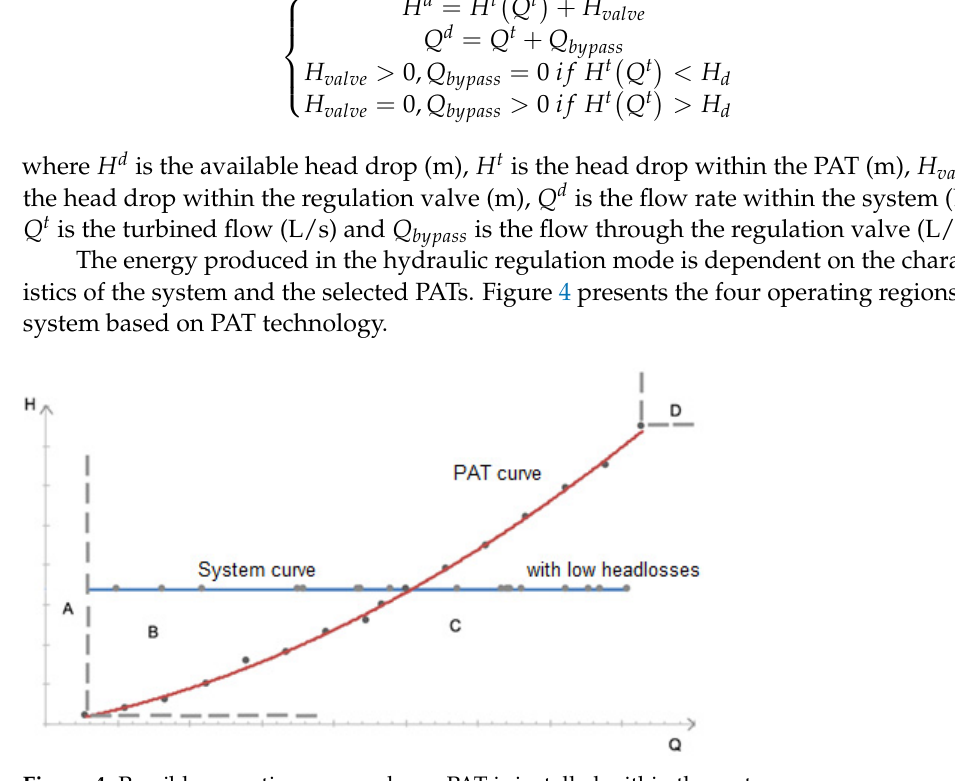
Figure 4. Possible operating zones when a PAT is installed within the system.